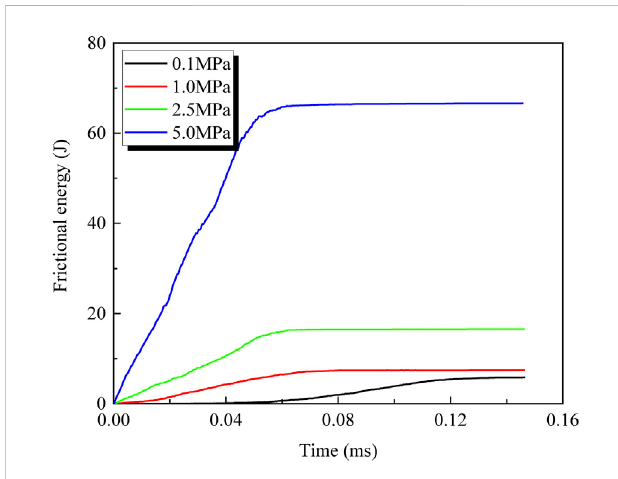
FIGURE 11 Change of frictional energy vs time for different pre-con fi ning